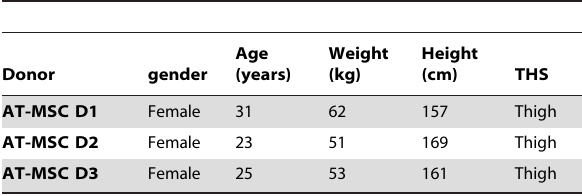
Table 1. AT-MSC donor demographics: gender, age, weight, height, and tissue-harvesting site